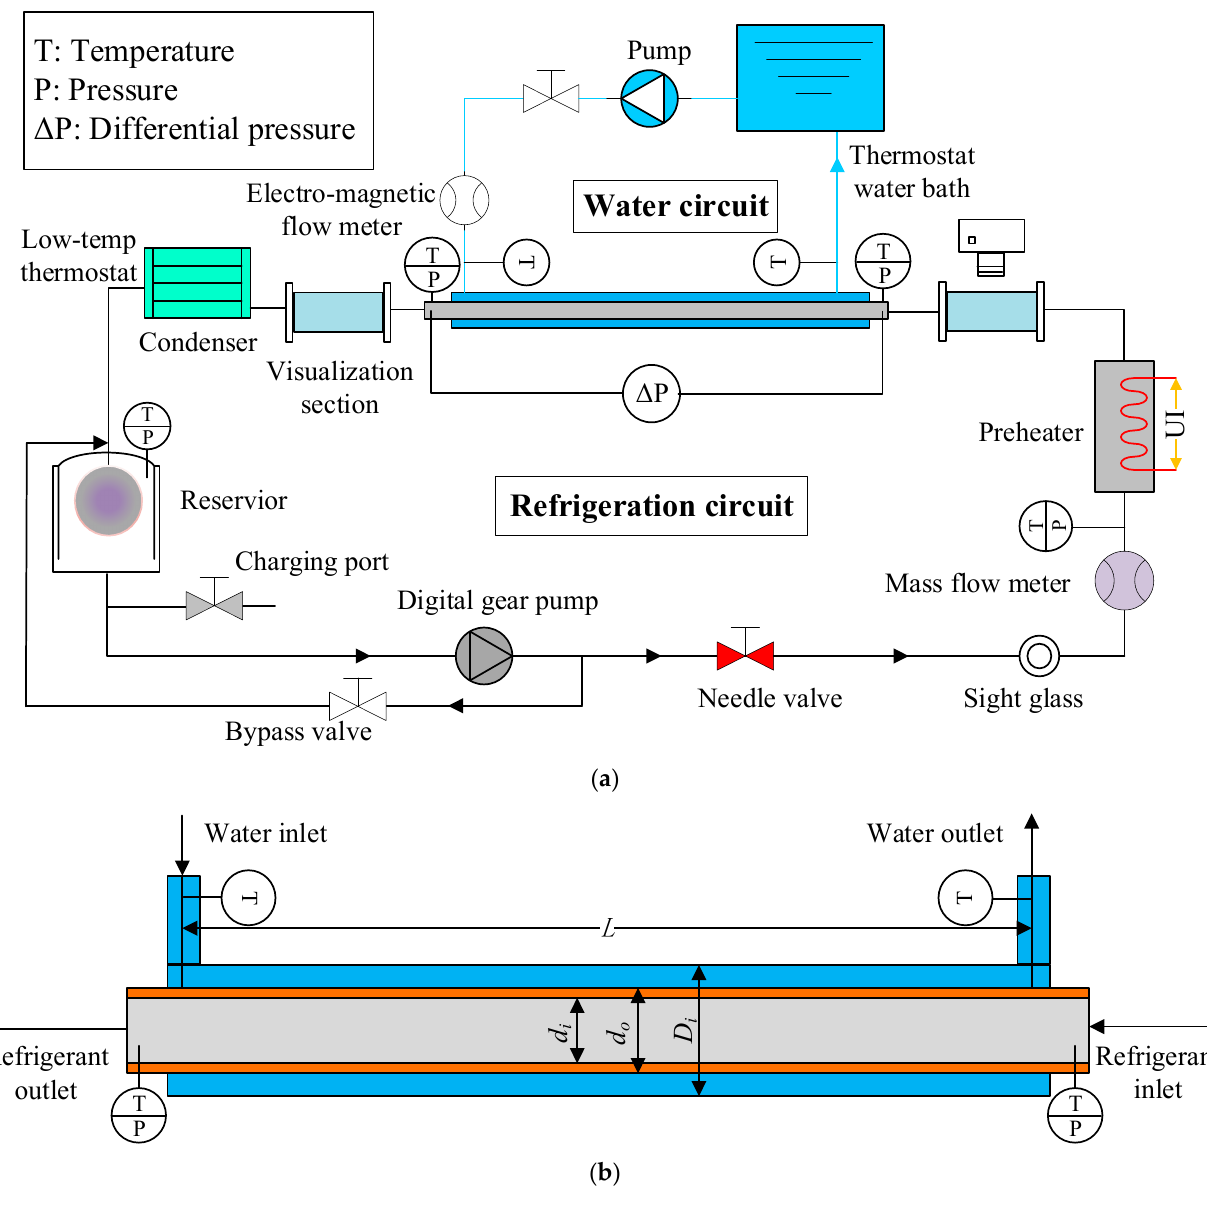
Figure 1. Schematic of the ( a ) experimental setup, ( b ) experimental test section.